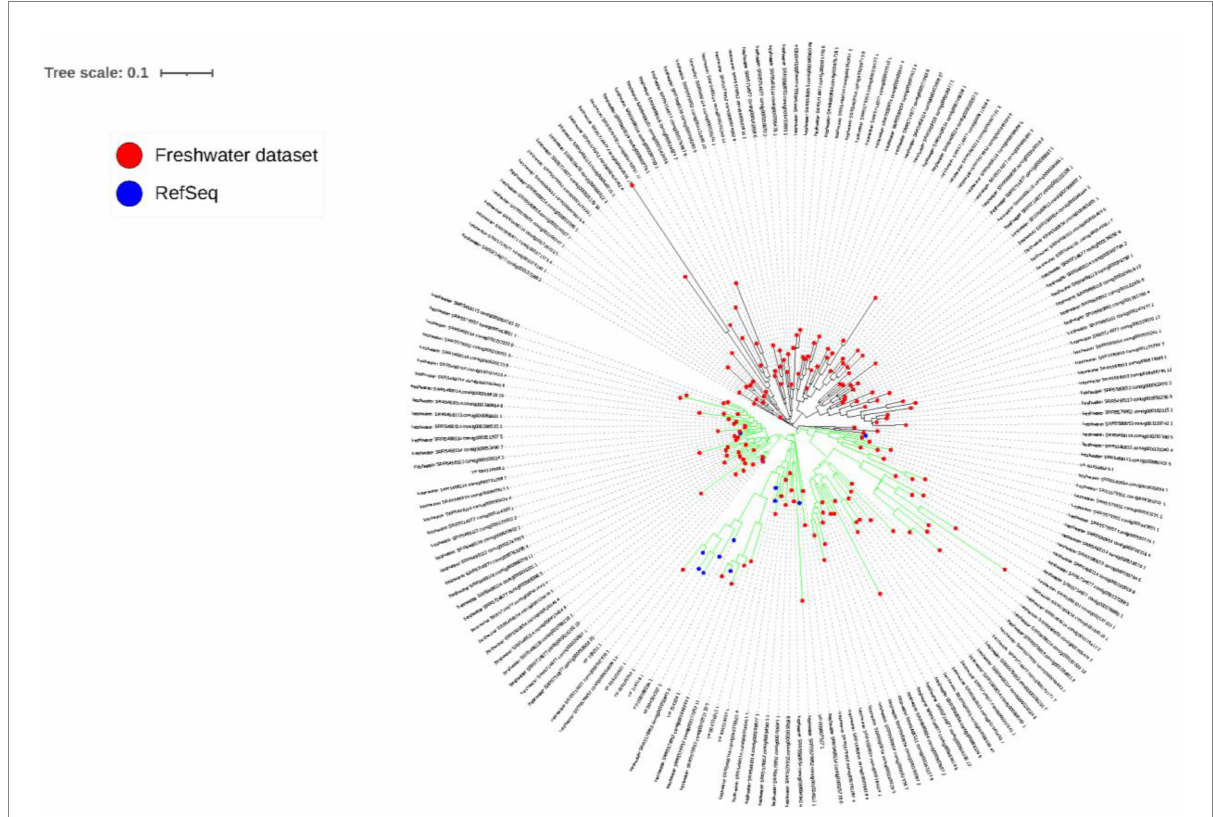
FIGURE 6 PsbA phylogenetic tree. Red circles at the tip of branches denote sequences identified in the current study, while blue circles denote RefSeq PsbA sequences collected from NCBI. Two main clades can be observed, whose branches are colored in green and